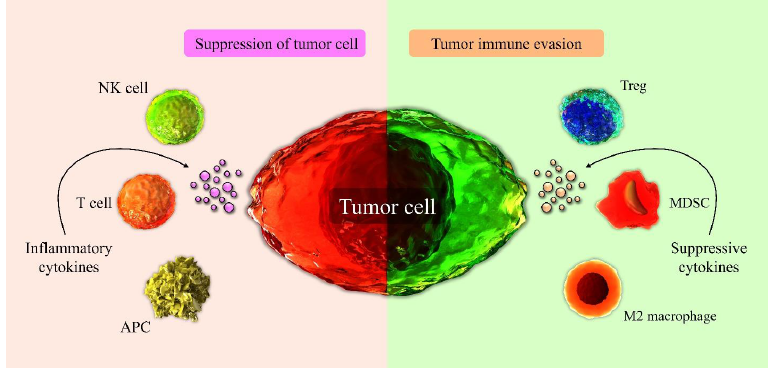
Figure 1. The tumor microenvironment is involved in tumor progression. In the TME, the populations of NK cells, APCs, and T cells exert an antitumor response and can lead to the suppression of tumor growth by producing inflammatory cytokines and causing the direct destruction of tumor cells. Conversely, the immunosuppressive microenvironment composed of inhibitory cells like Tregs, MDSCs, and M2 macrophages contributes to tumor development by attenuating the activity of antitumor immune cells.